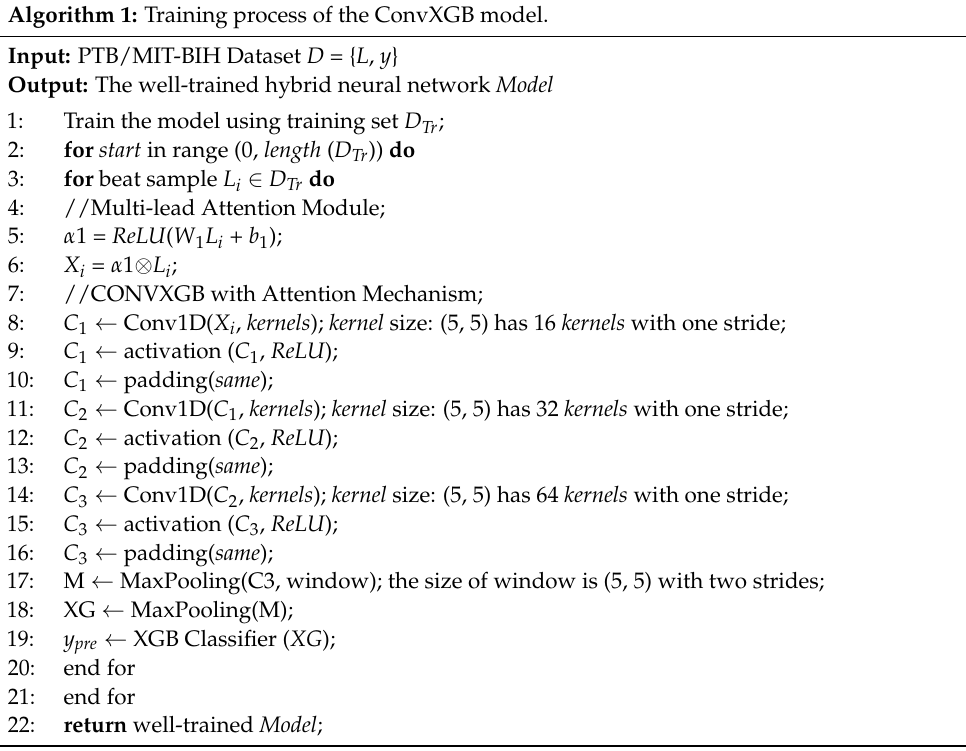
Algorithm 1: Training process of the ConvXGB